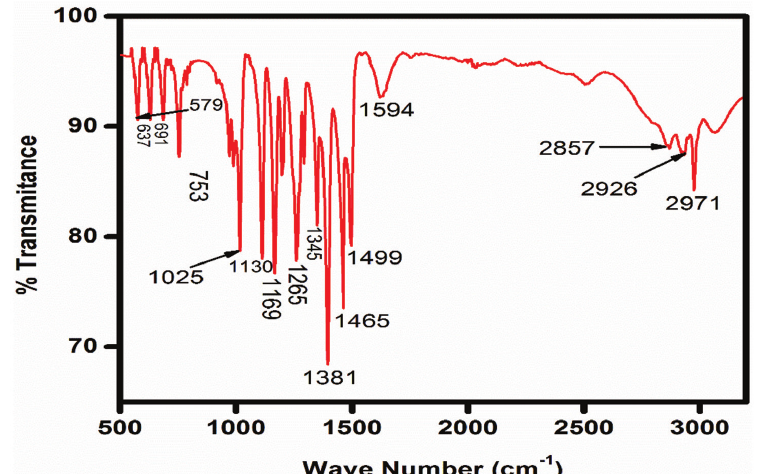
Figure A7: FT-IR spectrum of synthesized precursor